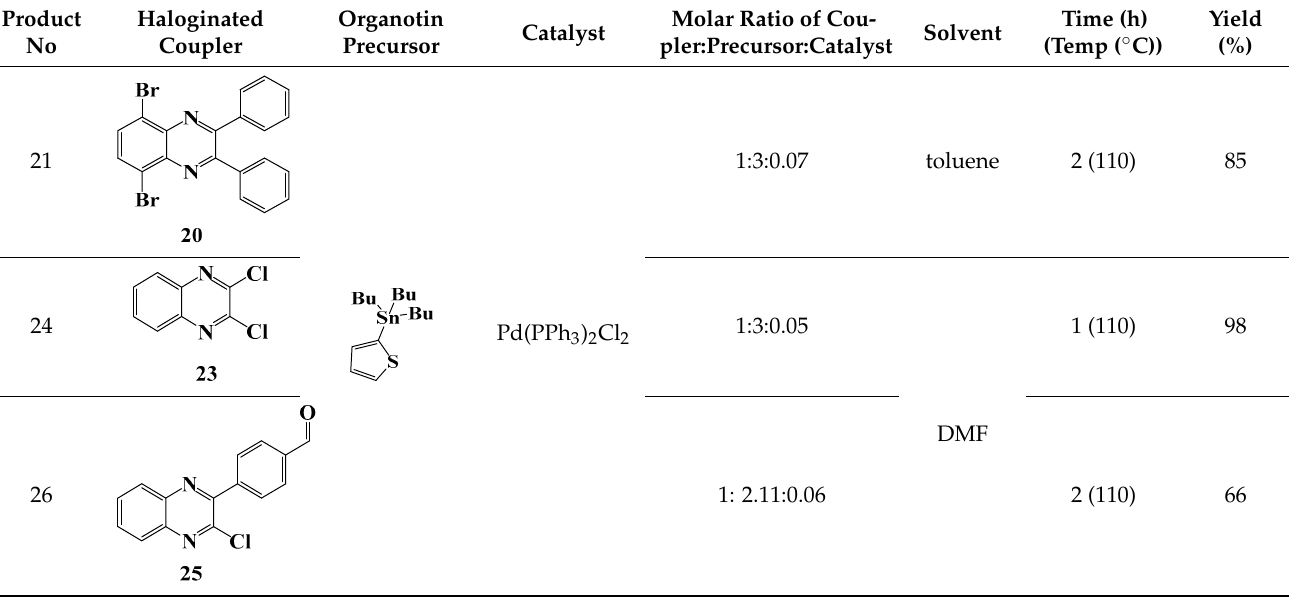
Table 3. Summary of Stille coupling reactions of halogenated QX couplers with commercial aryl- boronic acid precursors.